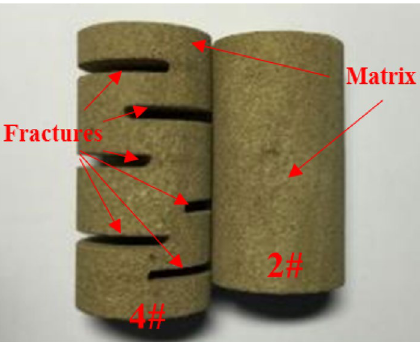
Figure 4. The picture of